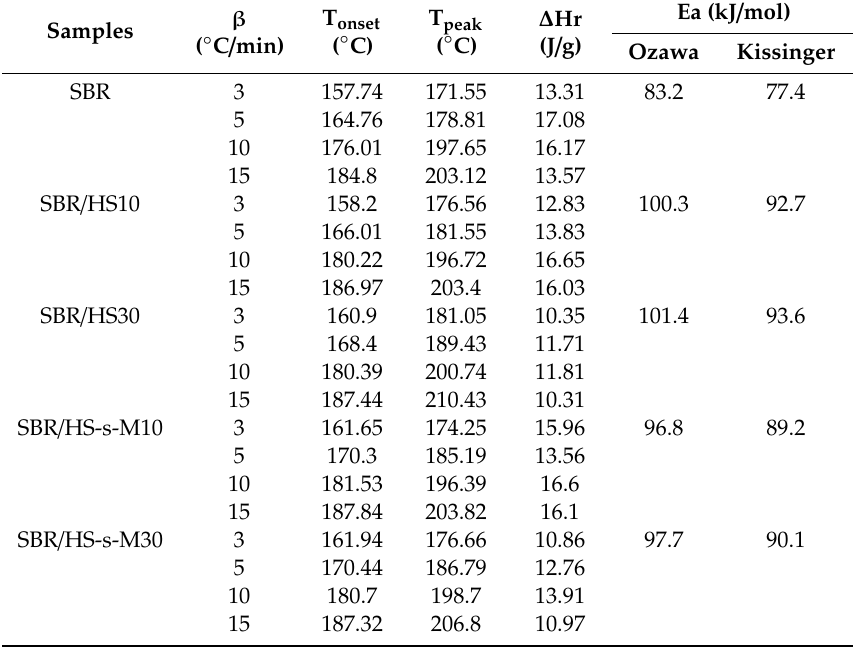
Table 2. Vulcanization characteristics and apparent activation energy (Ea) of SBR compounds obtained from